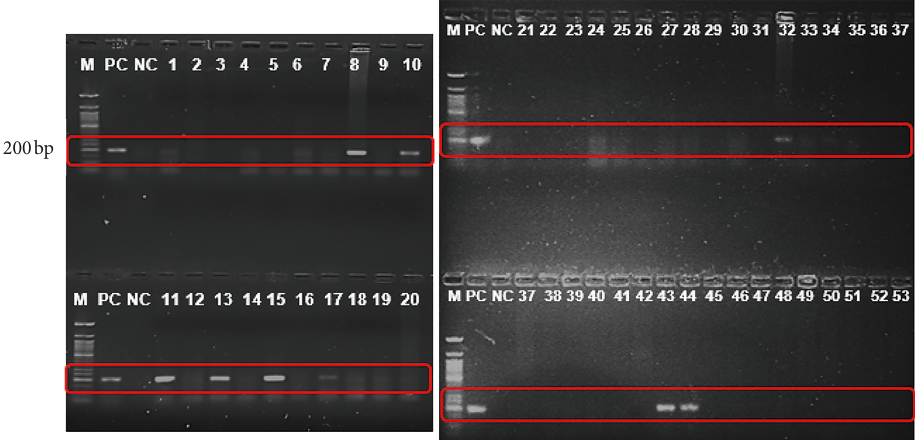
Figure 1: Amplification of TB with IS6110 primers. M: molecular weight marker, PC: positive control, NC: negative control, bp: base pairs (expected base pairs of Mycobacterium tuberculosis, 200 bp).